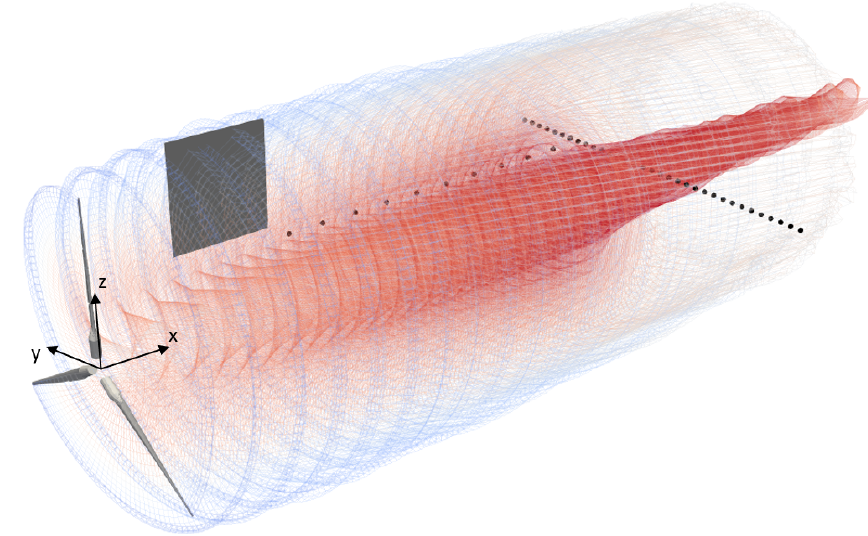
Figure 6. Wind turbine wake behavior in OpenFAST (free-vortex wake approach) during steady wind conditions.